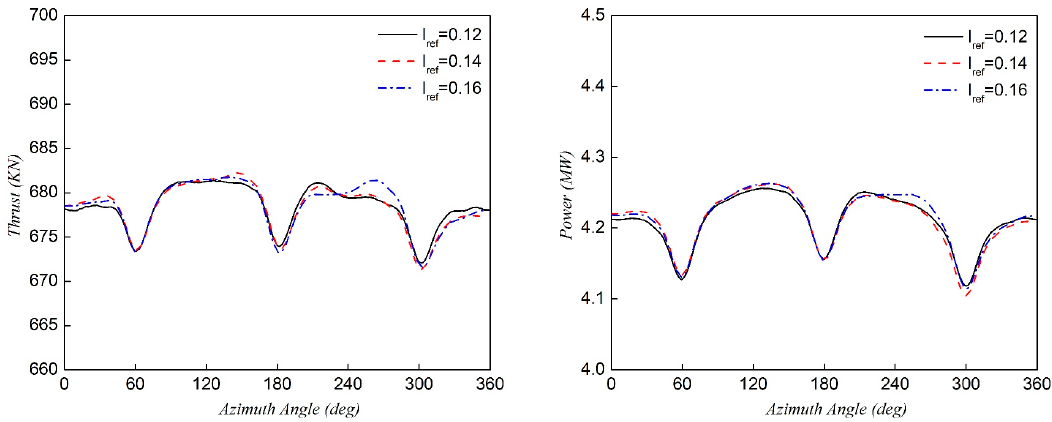
Figure 24. Thrust and power versus azimuth angle for various wind shear exponents ( γ ) at 𝑉 (cid:3035)(cid:3048)(cid:3029) = 11.4 m/s ( 𝐼 (cid:3045)(cid:3032)(cid:3033) = 0.14 , tilt angle = 4°)